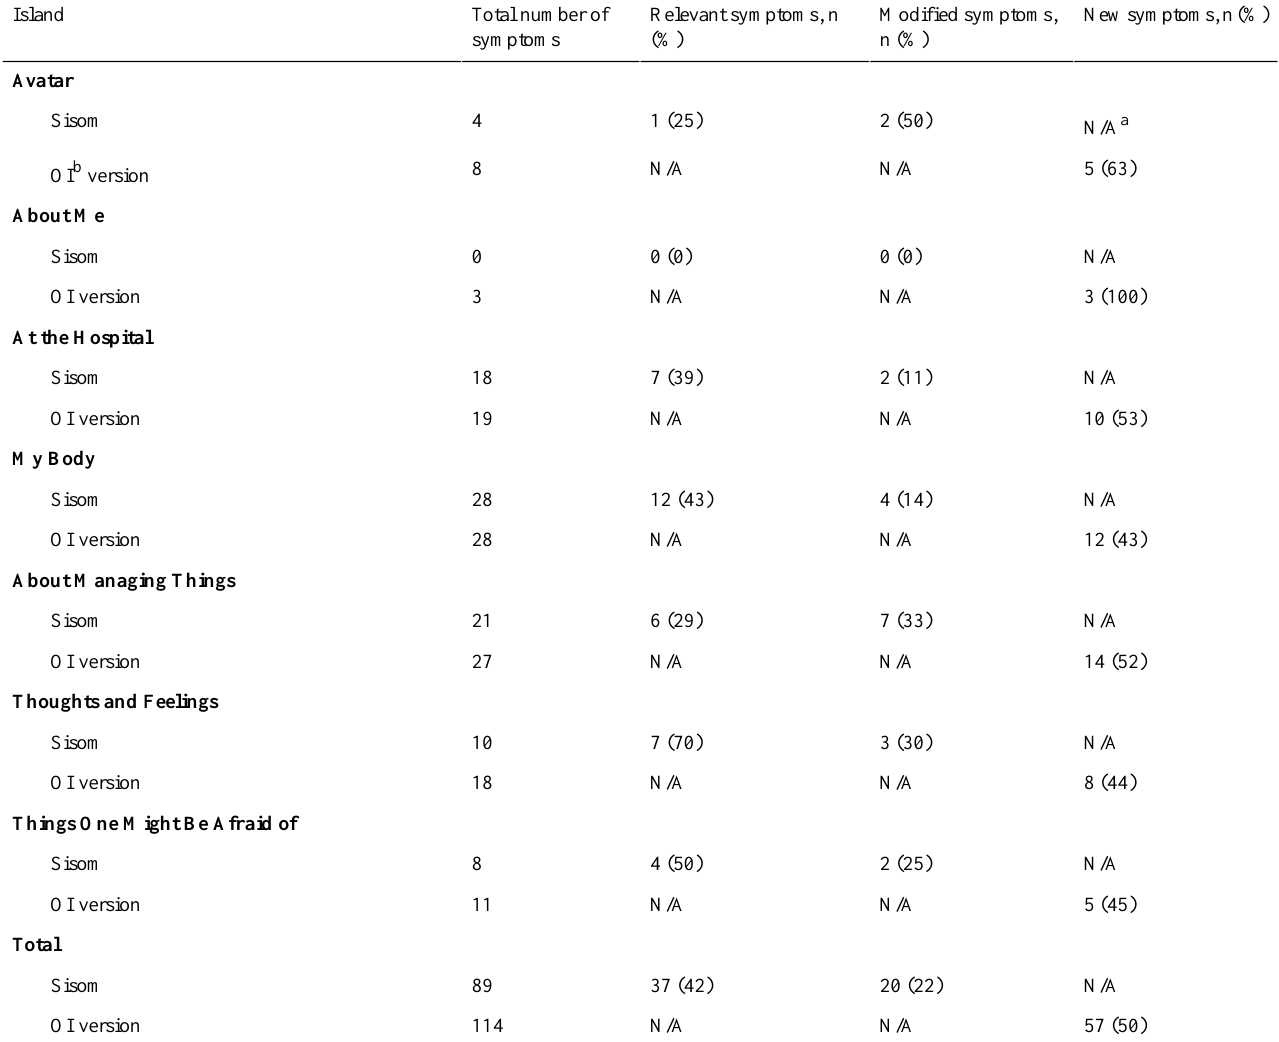
Table 3. Composition of the Sisom OI